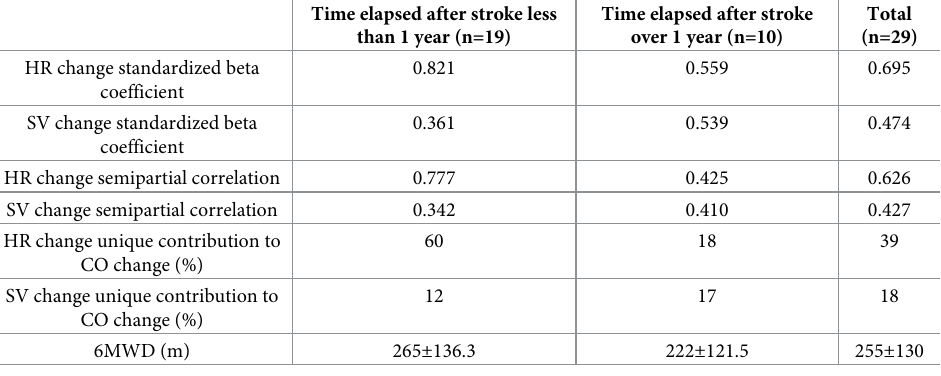
Table 3. Linear regression using cardiac output change as dependent variable and HR change or SV change as